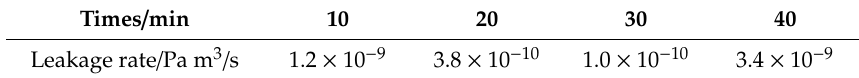
Table 5. Air tightness of the joints at brazing temperature of 495 ◦ C for di ff erent holding